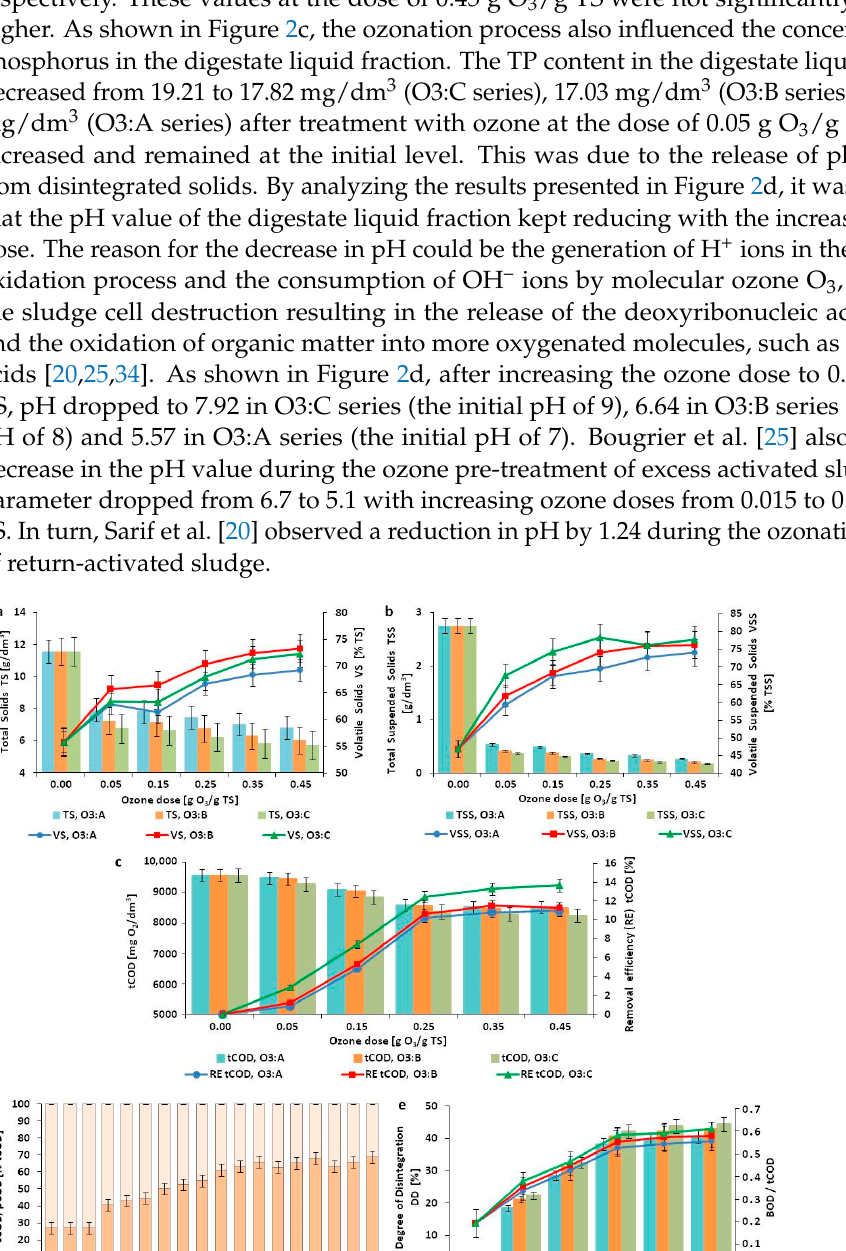
72.26 and 77.78%, 73.36 and 76.19%, 69.20 and 74.07%, respectively. The particle degra- dation in the ozonation process influenced changes in the COD distribution in the di- gestate liquid fraction (Figure 1c,d,e). By analyzing the results in Figure 1c, it was noted